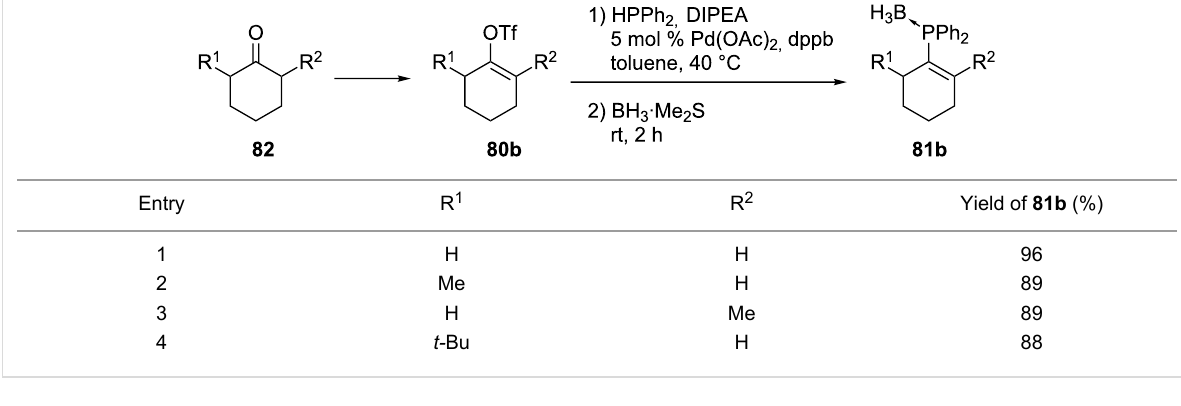
Table 9: Palladium-catalyzed synthesis of vinylphosphines 81b from ketones 82 (dppb = 1,4-bis(diphenylphosphino)butane).